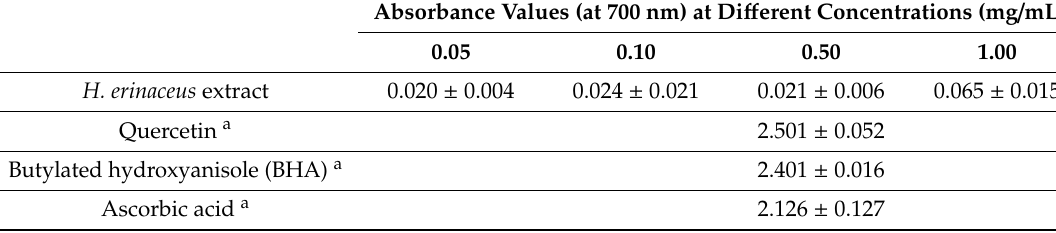
Table 5. Reducing power of Hericium erinaceus extract.